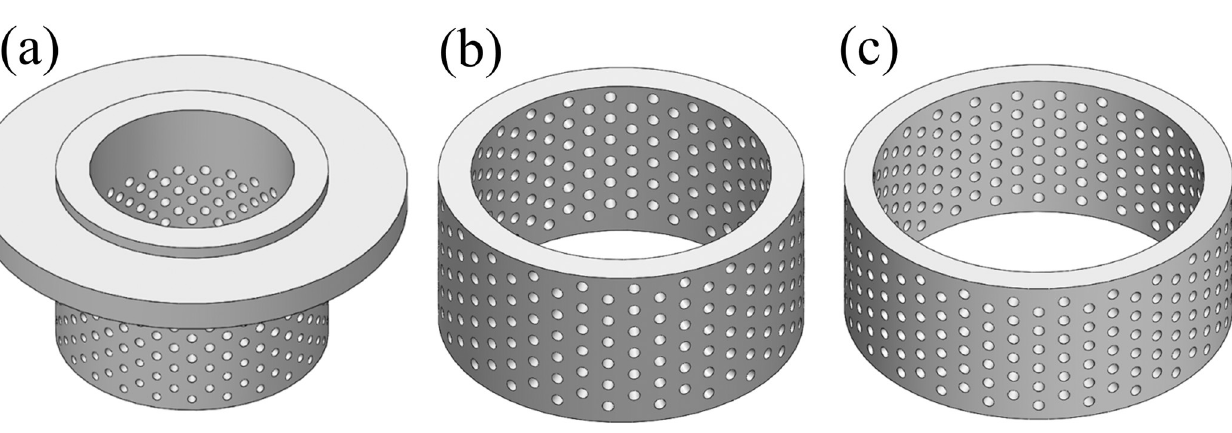
PLOS ONE | https://doi.org/10.1371/journal.pone.0266414 April 1,